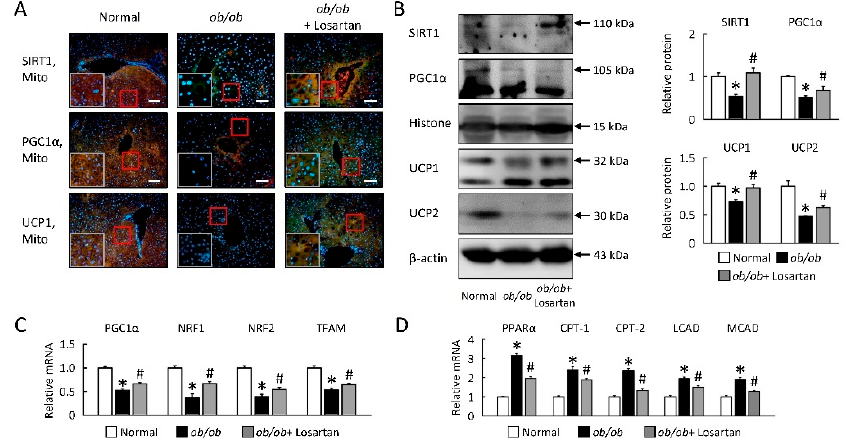
Figure 4. Losartan enhanced mitochondrial biogenesis and function in ob/ob mice. ( A ) The staining for SIRT1, PGC1 α , and UCP1 are green, while the staining for mitochondria (Mito Tracker) is red. Staining for DAPI is blue. Magnification of tissue samples is 20 × (red box) and for inset, magnification is 40 × (white box). Scale bar: 100 µ m. ( B ) Quantification of SIRT1, PGC1 α , UCP1, and UCP2 protein levels by Western blot of liver after losartan treatment. Right graphs indicate quantification relative to Histone (for SIRT1 and PGC1 α ) and β -actin (for UCP1 and UCP2). Quantification of ( C ) PGC1 α , NRF1, NRF2, TFAM, ( D ) PPAR α , CPT-1, CPT-2, LCAD, and MCAD by qRT-PCR. qRT-PCR indicate quantification relative to GAPDH. For each animal group, n = 5. All values represent the mean ± SEM. Data were analyzed by Student’s t test. * p ≤ 0.05; normal vs. ob/ob . # p ≤ 0.05; ob/ob vs. ob/ob + Losartan. SIRT1, sirtuin-1; PGC1 α , peroxisome proliferator-activated receptor gamma coactivator 1-alpha; PPAR, peroxisome proliferator-activated receptor; UCP1, uncoupling protein 1; NRF, nuclear respiratory factor; TFAM, mitochondrial transcription factor A; CPT, carnitine palmitoyltransferase; LCAD, long-chain acyl-CoA dehydrogenase; MCAD, medium-chain acyl-CoA dehydrogenase.